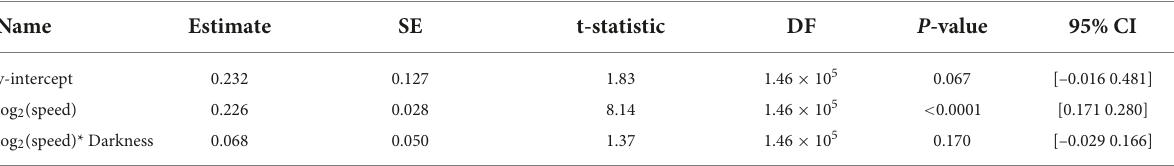
TABLE 3 Results of a linear mixed-effects model of the z-scored (cid:49) F/F of cholinergic activity during stationary behavioral activity with three fixed effects, namely the y-intercept, the logarithm of allocentric neck movement speed, and the interaction between the logarithm of allocentric neck movement speed and